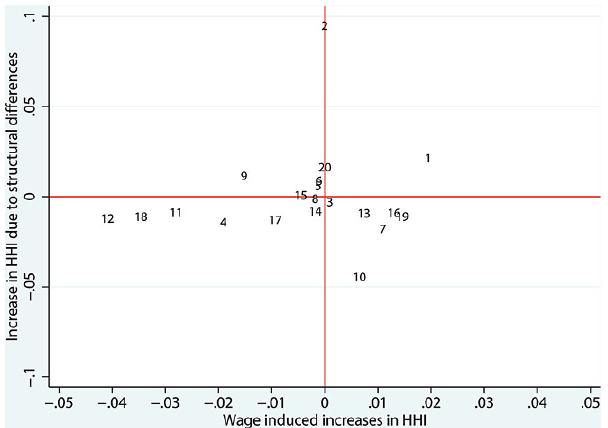
Fig. 3 Differences in HHI due to structural change (2030–2011) and wage development (‘no wage response’ vs. ‘baseline’). Source: QuBe project 3 rd wave; own